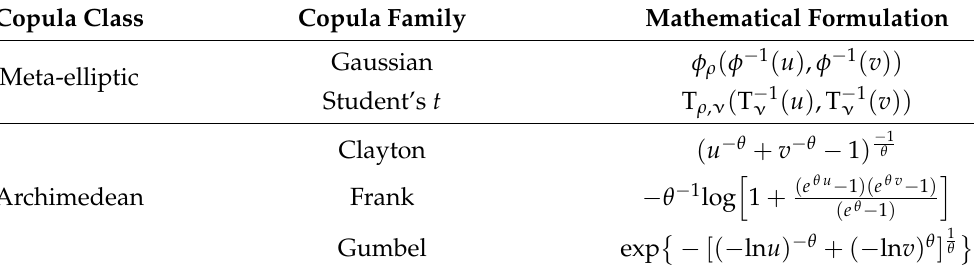
Table 2. Copula candidate family and mathematical